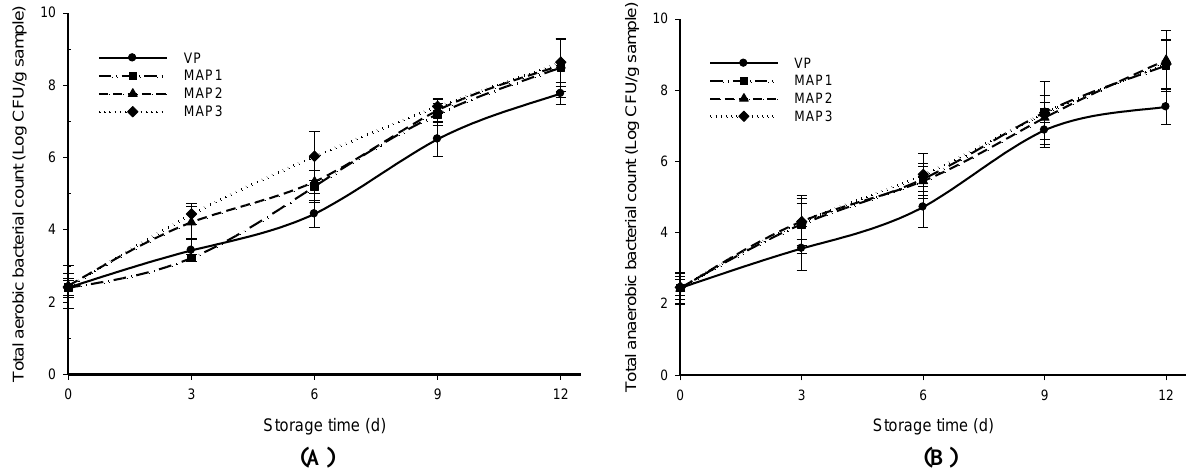
Figure 3. Effect of gas composition in modified atmosphere packaging on total aerobic (A) and anaerobic bacteria (B) of Longissimus dorsi of Korean Native Black Pig crossbred with Duroc during refrigerated storage. VP, vacuum packaging; MAP, modified atmosphere packaging. MAP1 = 0:20:80/O 2 :CO 2 :N 2 , MAP2 = 30:20:50/O 2 :CO 2 :N 2 , MAP3 = 70:20:10/O 2 :CO 2 :N 2